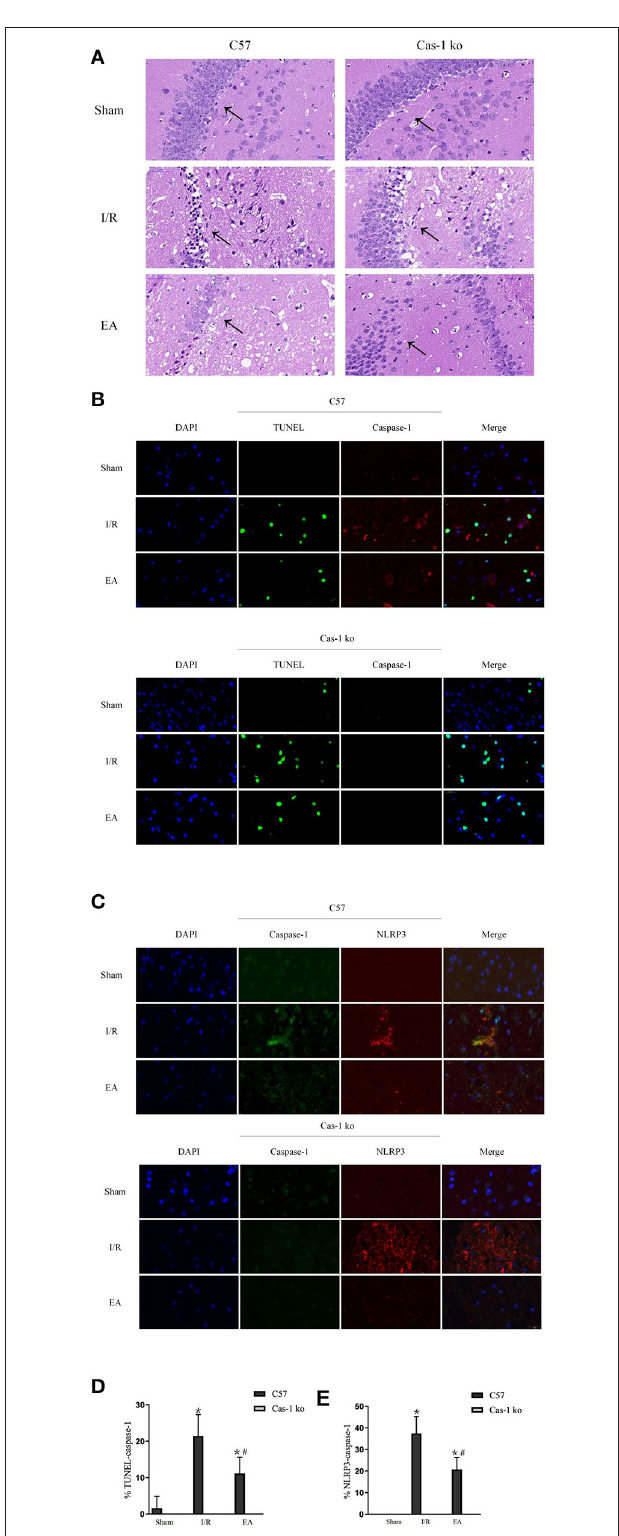
FIGURE 3 | Morphological observation of neuronal injury in hippocampus after I/R injury. (A) Pathological HandE staining of neurons in hippocampus. (B,D) TUNEL (green)/caspase-1 (red) double-labeled staining of neurons in